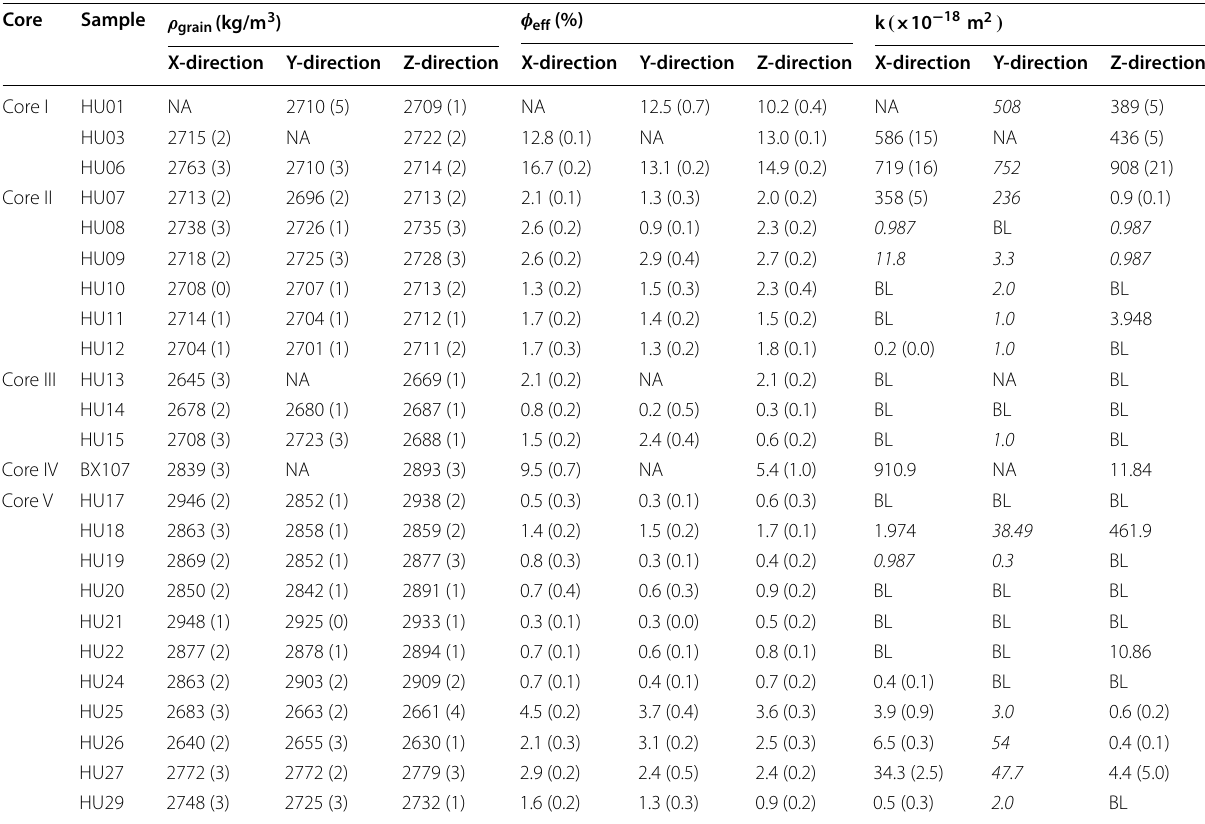
Table 2 Summary of the grain density; ρ grain (kg/m 3 ), effective porosity; φ eff (%), and permeability; k ( m 2 ) for the studied